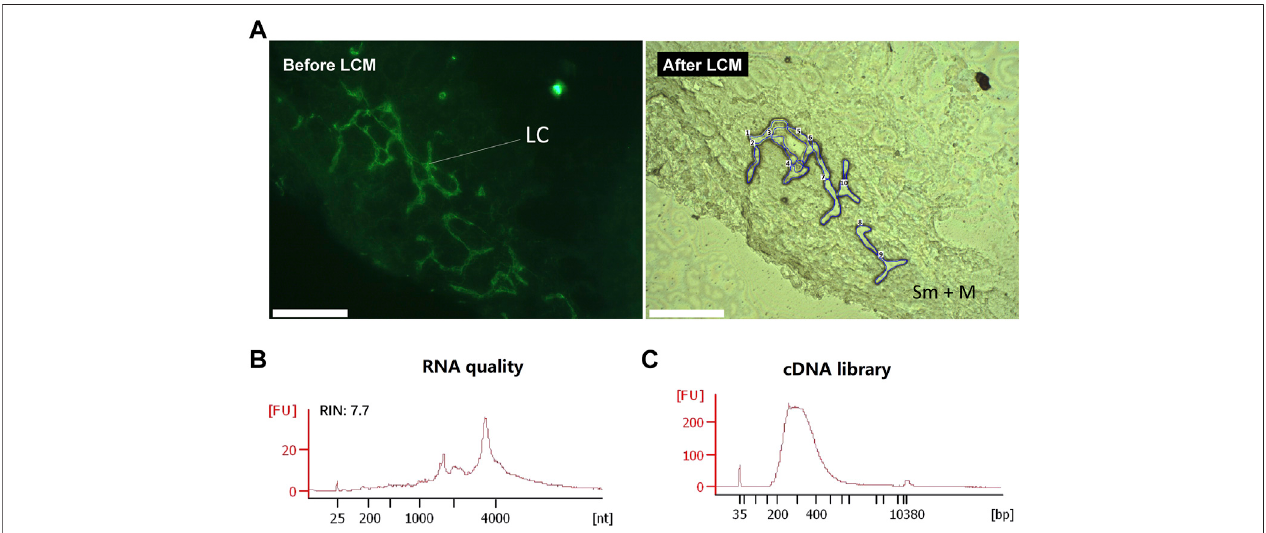
FIGURE8| Immuno-LCM-RNAseqofthehumanjejunumlymphaticvesselfromaclinical,RNAlater-preservedjejunumtissue. (A) Left:Immuno fl uorescenceimage of the lymphatic vessels in the human jejunum tissue section using an anti-Podoplanin antibody (with 10 mM RVC). Right: bright fi eld image after LCM. LC: lymphatic cells; Sm: submucosal layer; M: muscle layer (B) RNA quality of the leftover materials after LCM. (C) The quality of the cDNA library prepared from this RNA. Scale bar: 200 μ m.